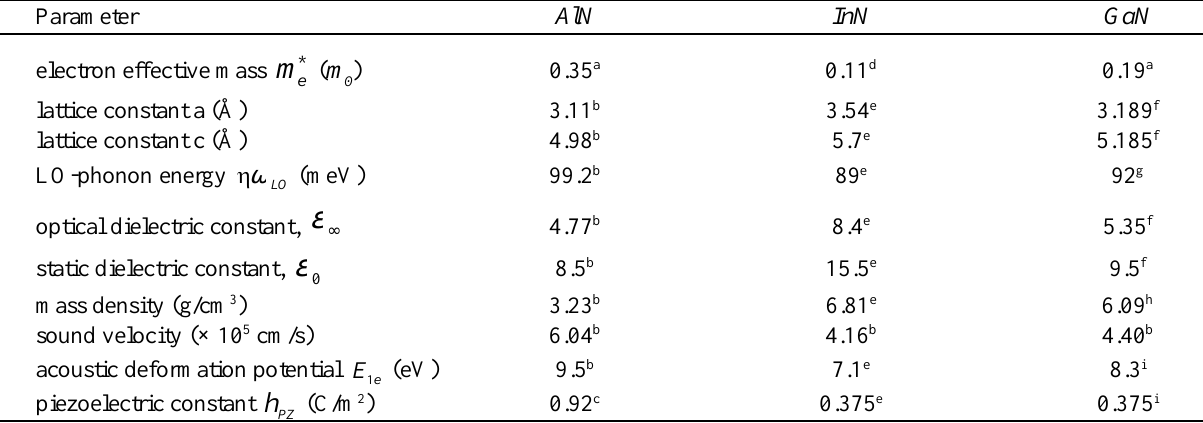
Table 1. Parameters of wurtzite AlN, InN, and GaN used in the numerical solution of the transport equations.